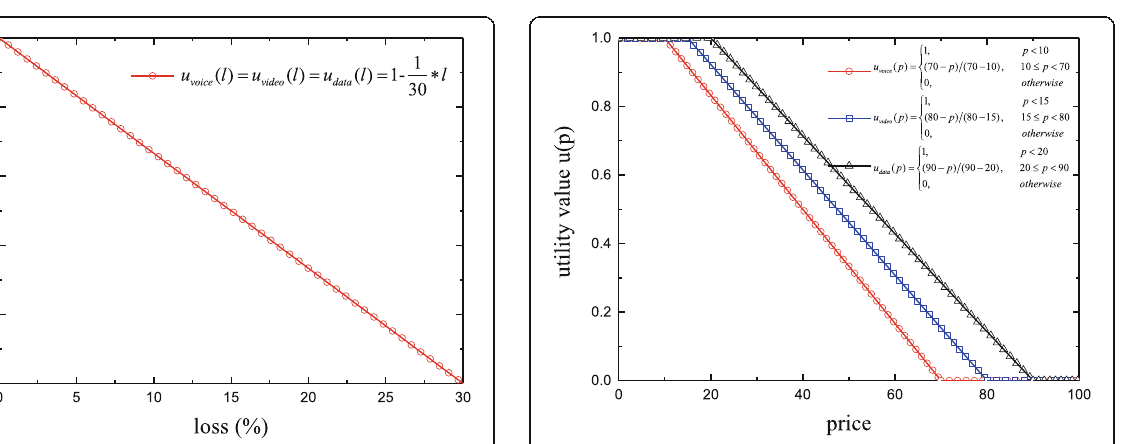
Fig. 8 Price utility function curve for voice, video, and data